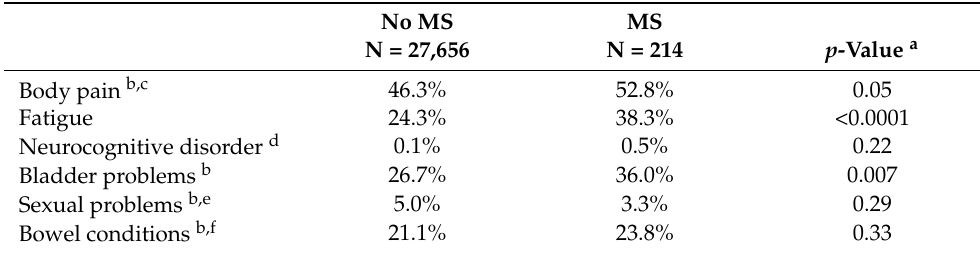
Table 4. Prevalence [number (%)] of self-reported physical and cognitive health conditions among women with and without MS in the SAGA